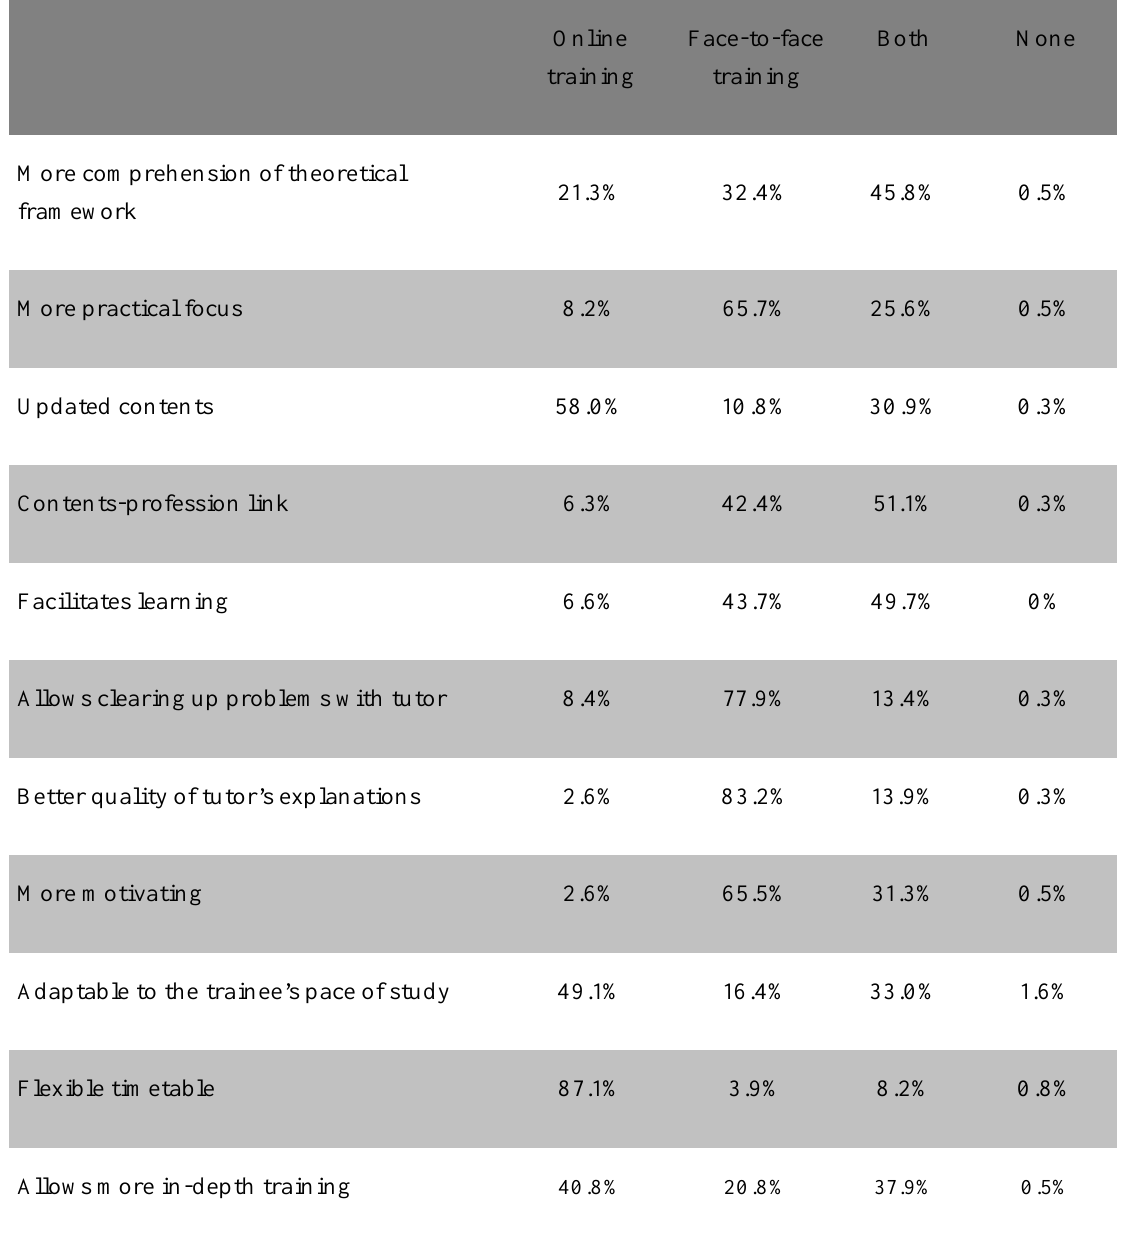
Table 3 Association of Attributes to each Type of Training (% of Employees)